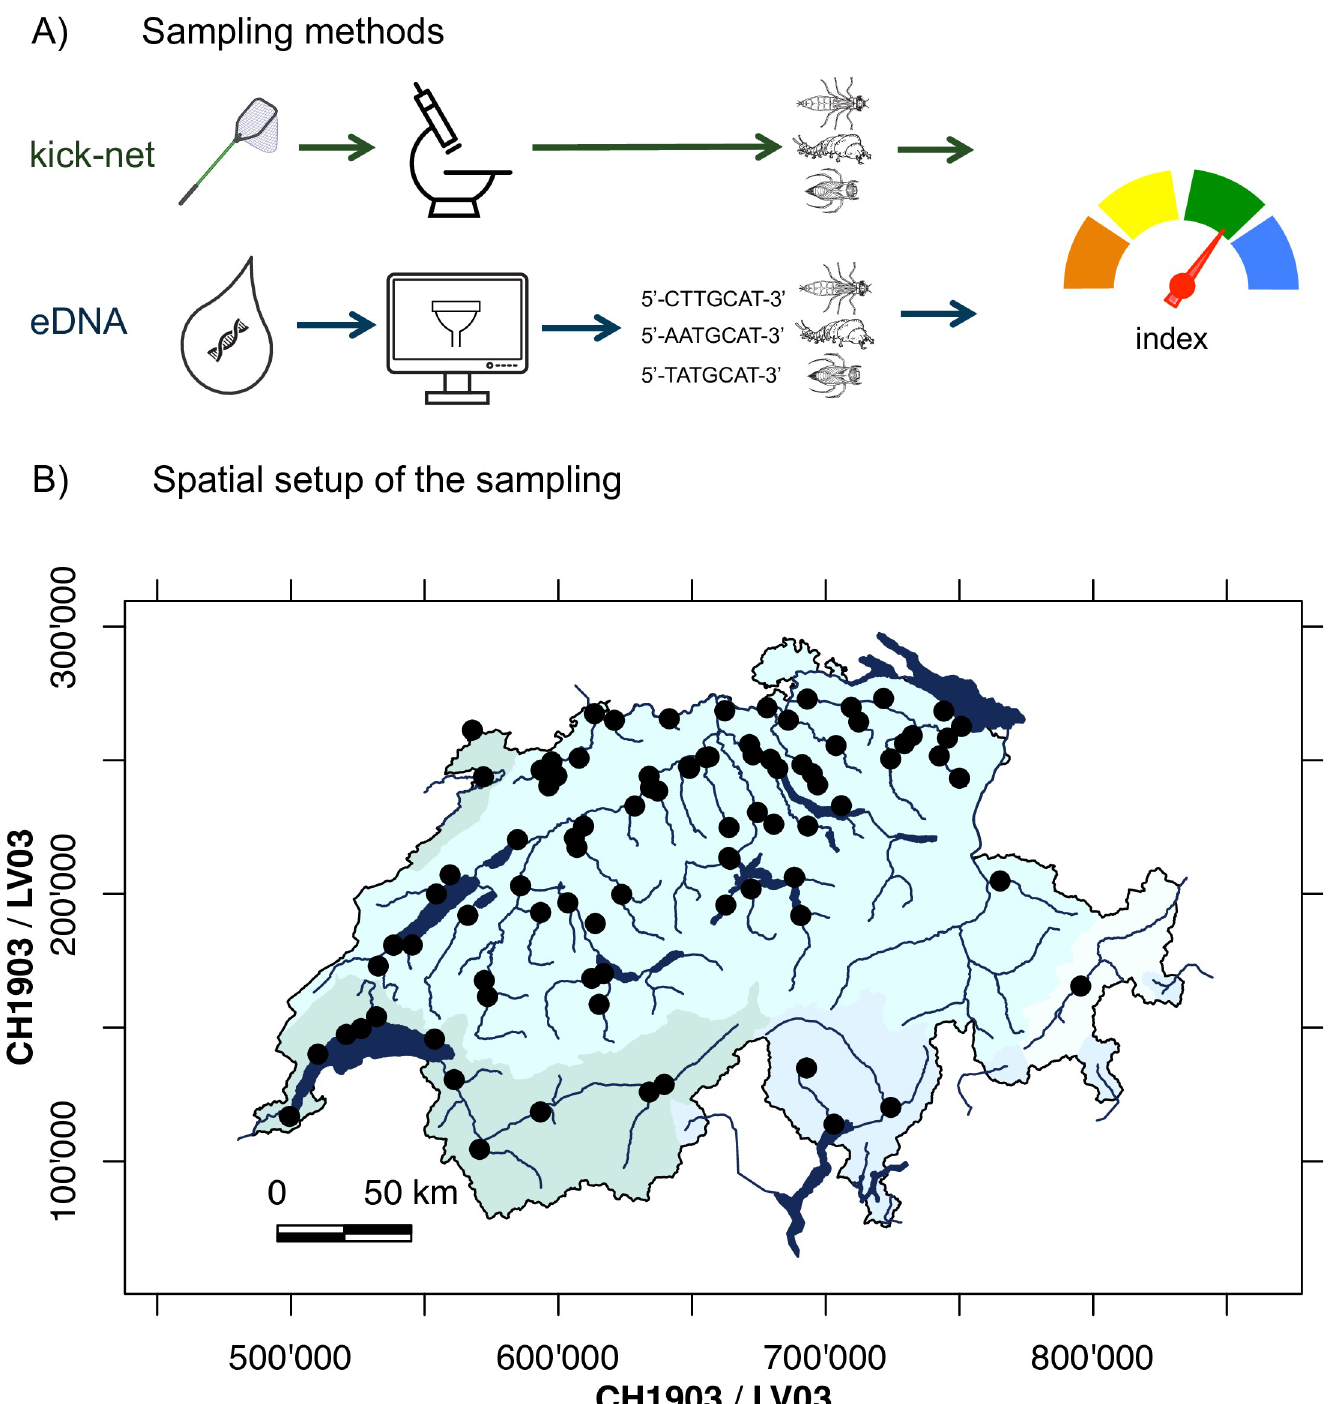
Fig 1. Description of the study design. A) The taxonomic composition of benthic macroinvertebrates at each sampling site was assessed with two methods: Kick-net and eDNA sampling. Subsequently, the focal index on the biological state (IBCH Index) was calculated from kick-net and eDNA data. B) Map of Switzerland showing the spatial setup of the biomonitoring sampling sites. Sampling sites are given as black points overlaid on the main network of rivers and lakes. Different blue shading highlights major catchments of Switzerland.